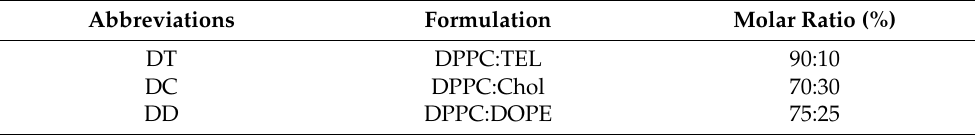
Table 1. Lipid compositions of the liposomal formulations. The lipids